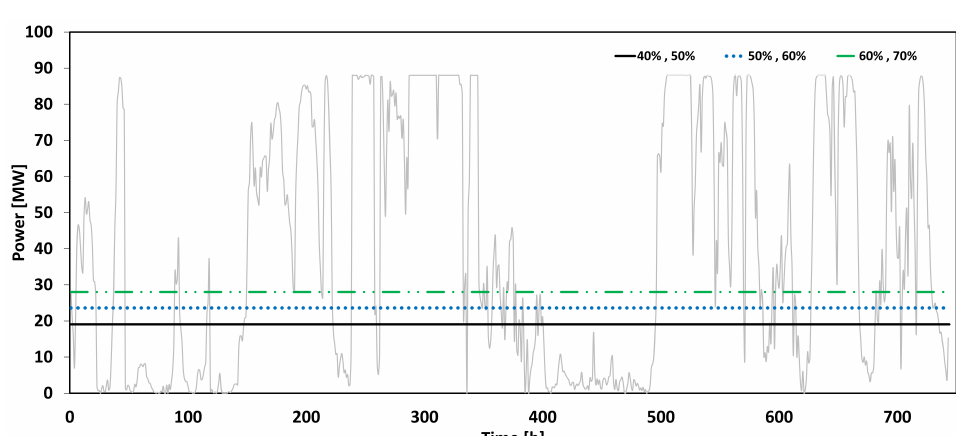
Figure 7. Power storage versus time.